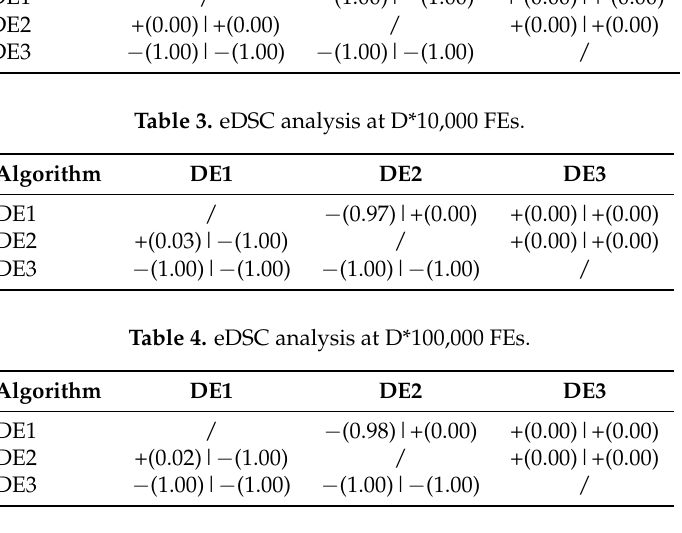
Table 5. eDSC analysis at max FEs,